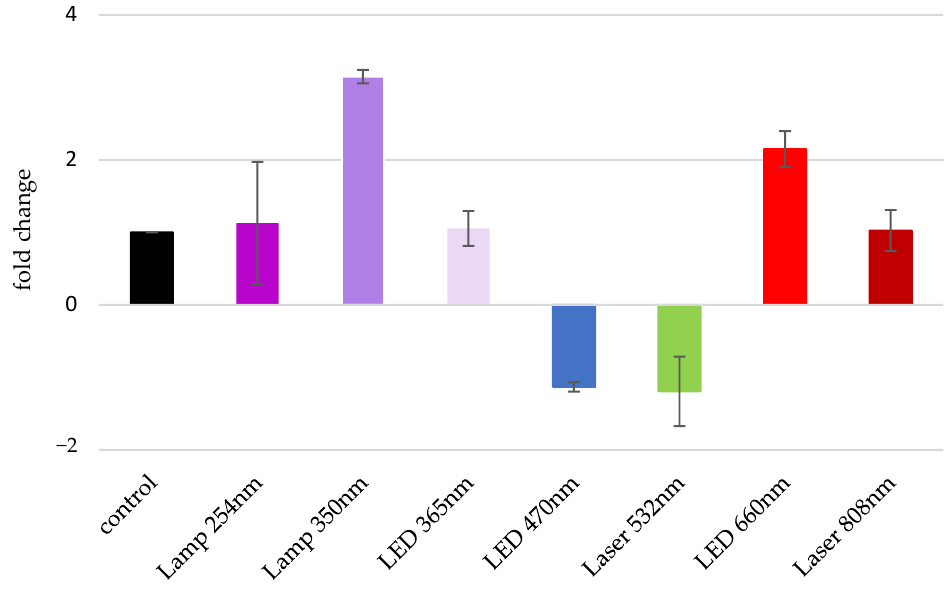
Figure 5. Changes in MAOA gene expression have been studied after SMT irradiation in vitro with light sources emitting ER in UV, Vis and NIR ranges for 60 s. All comparisons are between irradiated and the control gastric SMT. The number of conducted experiments was n = 3. The results are presented as MEAN ± STDV. Statistical significance is designated at p < 0.05.